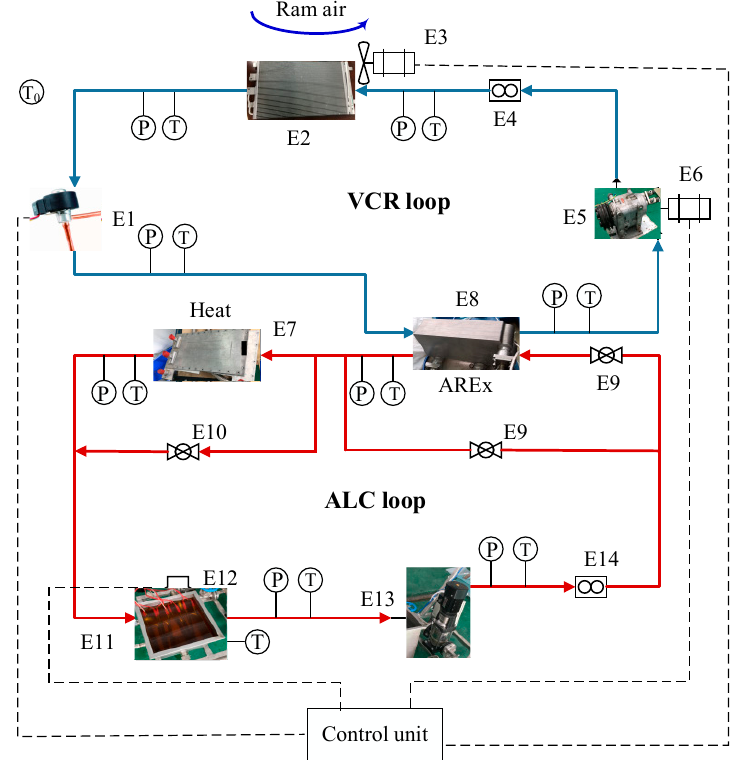
Figure 1. Schematic diagram of thermal management system (TMS) based on antifreeze liquid cooling (ALC) and vapor compression refrigeration (VCR) loops (E1, EEV; E2, condenser; E3, fan; E4, mass flow meter; E5, compressor; E6, electric motor; E7, cold plate; E8, evaporator; E9, temperature control valve; E10, relief valve; E11, heater; E12, antifreeze tank; E13, pump; E14, volume flow meter; T0, ground ambient temperature; T, temperature sensor; P, pressure sensor).